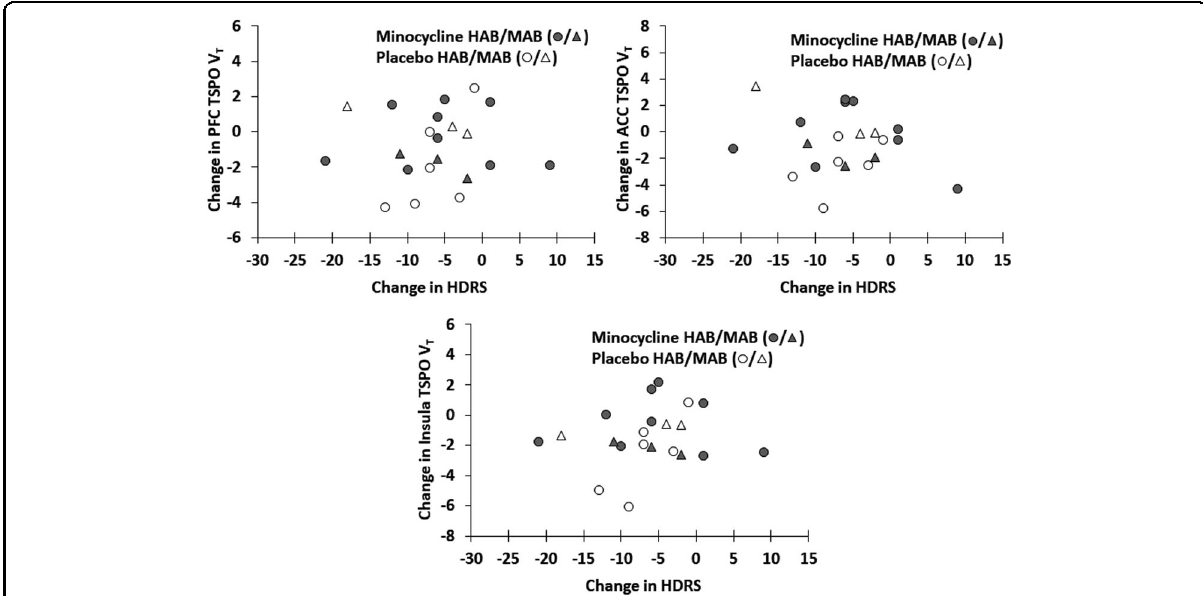
Fig. 3 Relationship between change in regional translocator protein total distribution volume and change in hamilton depression rating scale scores. There were no signi fi cant relationships between the change in prefrontal cortex, anterior cingulate cortex, or insula TSPO V T with change in HDRS scores (repeated measures ANOVA, TSPO V T as dependent variable, effect of HDRS change as covariate, F 1,19 = 0.66 – 0.06, P = 0.43 – 0.82). Similarly, nonsigni fi cant effects were observed within the minocycline treated group alone. ACC anterior cingulate cortex, HAB high- af fi nity binder, HDRS Hamilton Depression Rating Scale, MAB mixed-af fi nity binder, PFC prefrontal cortex, TSPO V T translocator protein total distribution